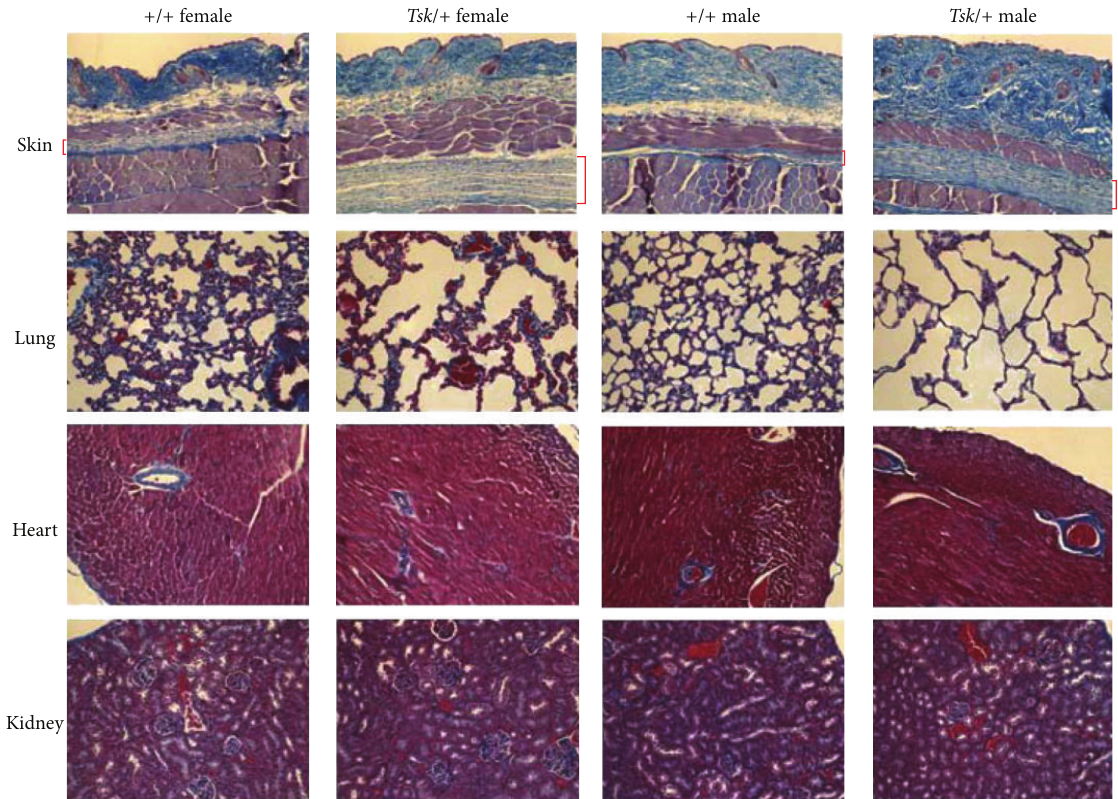
Figure 2: Histopathology of tissues from wild type +/+ and mutant Tsk /+ mice . The genotype and gender of the mice are shown at the top. The tissue is shown at the left of the figure. Skin, lung, heart, and kidney samples from mice were removed, fixed, paraffin-embedded, sectioned, and stained with Masson’s trichrome. Collagen staining appears in blue. Compare the thickness of the collagen-containing dermal layer and the hypodermal or superficial fascia layer (shown in red brackets) beneath the panniculus carnosus in the skin. The age of the mice ranged between 23 and 27 weeks. Magnification is 200x. Table 2: Hydroxyproline content in lung, heart, and kidney of B6 +/+ and B6 Tsk /+ mice.